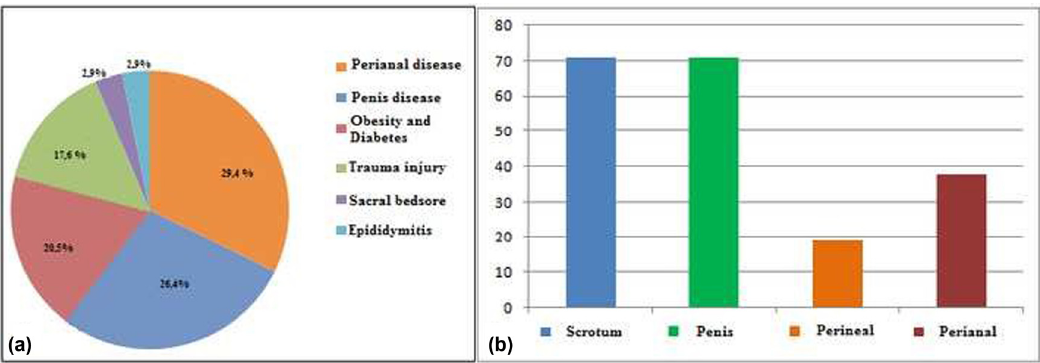
Figure 1: ( a ) Diseases observed at the origin of the infective process. ( b ) Percentage of the anatomical regions interested by the gangrene.